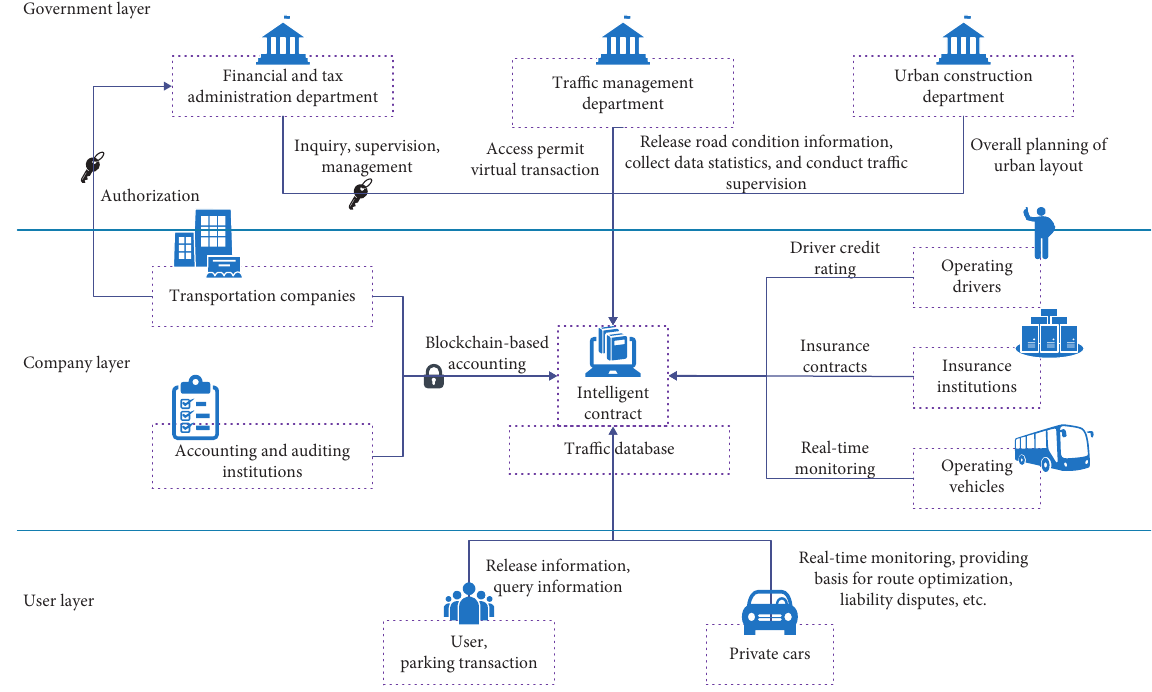
Figure 3: Blockchain-based intelligent transportation sustainable GCU application